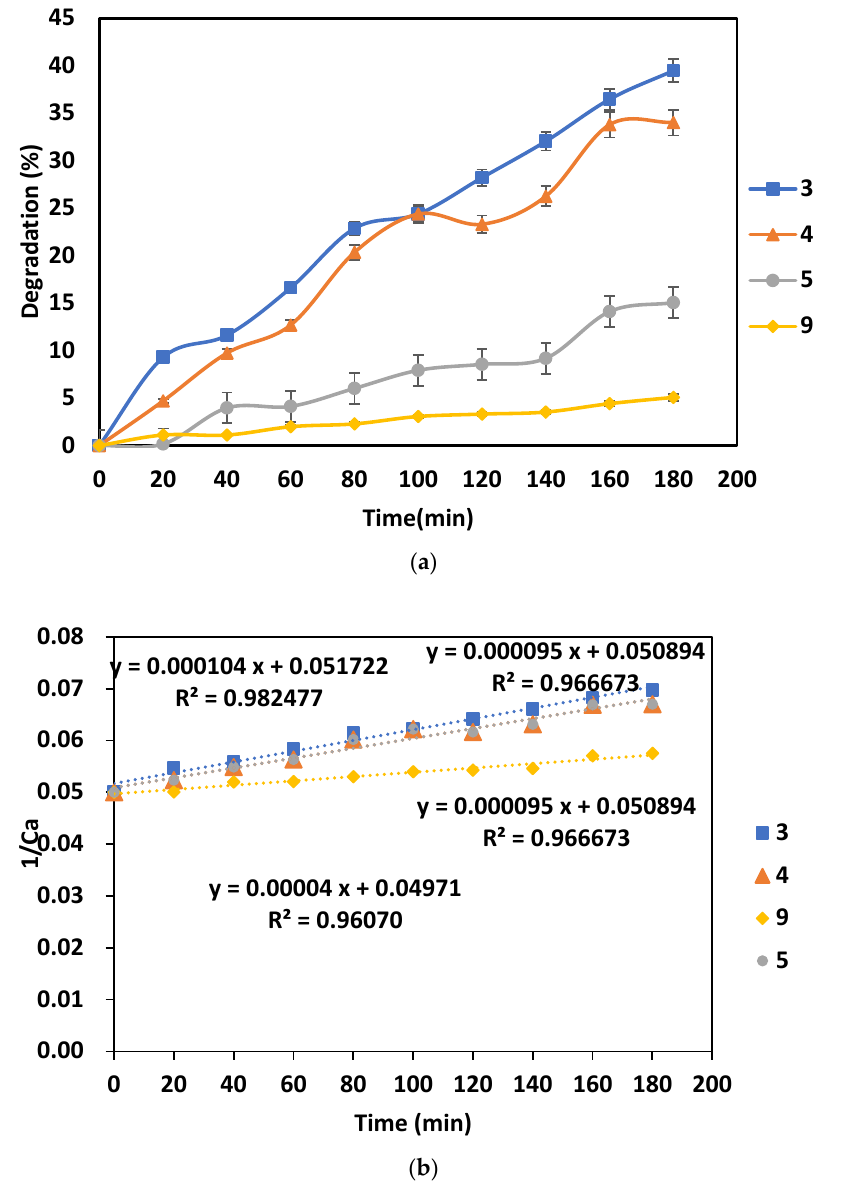
Figure 3. Effect of pH on the degradation of Chrysoidine R dye: ( a ) extent of degradation and ( b ) kinetic fitting. Table 1. Extent of degradation and kinetic rate constant data at various